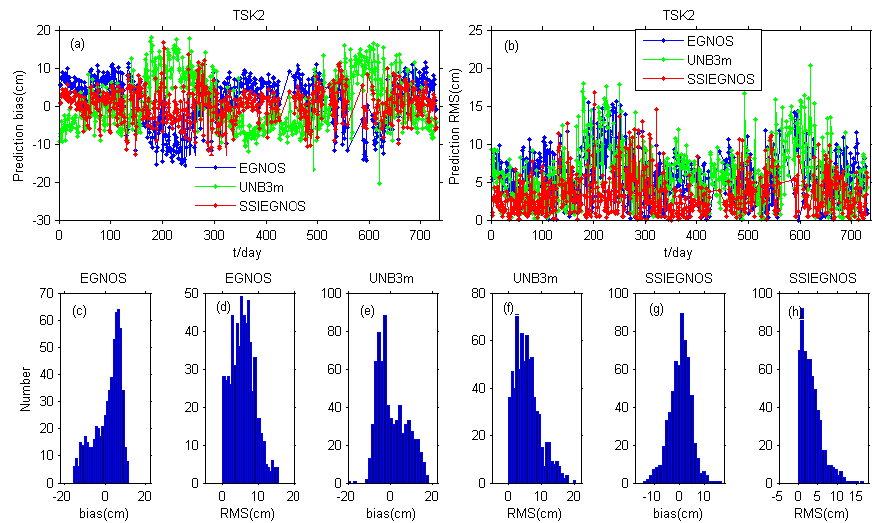
Figure 15. ( a , b ) Time series of daily predicted bias and RMS error from 2011–2012 at the TSK2 site. The blue line denotes the EGNOS model, the green line denotes the UNB3m model, and the red line denotes the SSIEGNOS model. ( c – h ) Histograms of the daily predicted bias and RMS error from 2011–2012 for the three models.